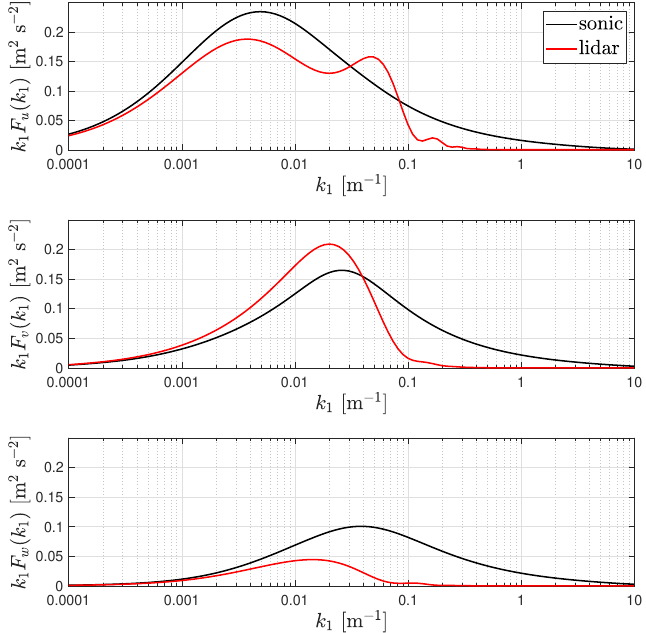
Figure 2. Velocity spectra ( u -top, v -middle, and w -bottom) for an ideal sonic anemometer and a ZX lidar measuring at a height of 50 m with α(cid:101) 2/3 = 0.1 m 4/3 s − 2 , L = 50 m, and Γ =